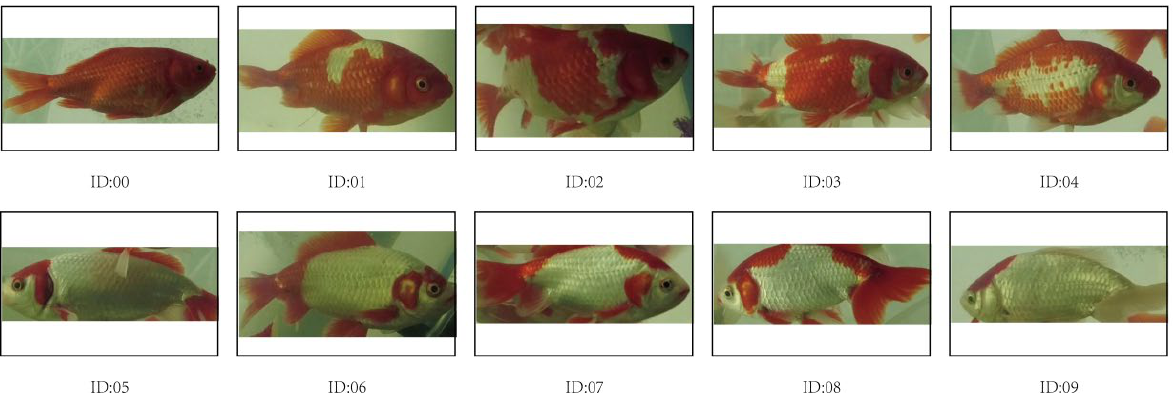
Figure 2. Mapping between ID and fish. An ID was defined for each fish initialization. A total of 10 fish had different IDs, which were not changed during the whole experiment.